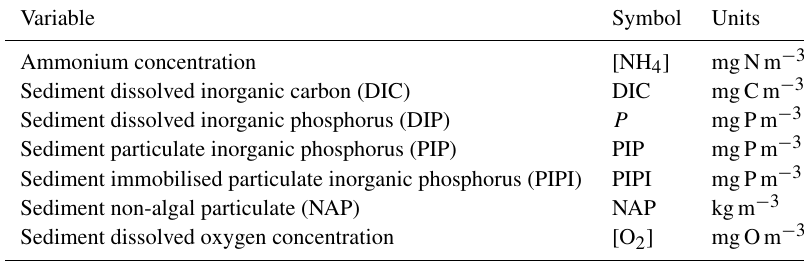
Table 34. State and derived variables for the sediment inorganic chemistry model.